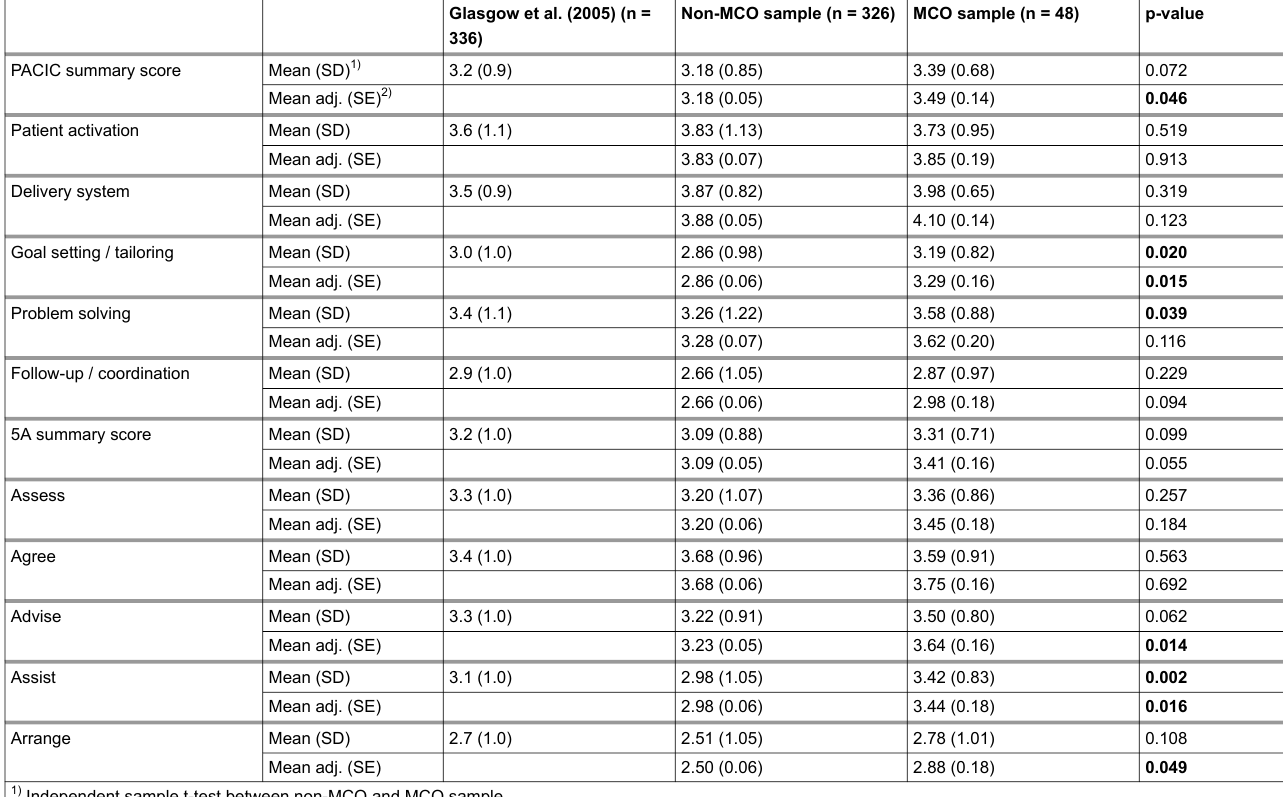
Table 2: Results for PACIC summary score, 5A summary score and PACIC subscales per non-managed care and managed care patients in comparison to the original data.